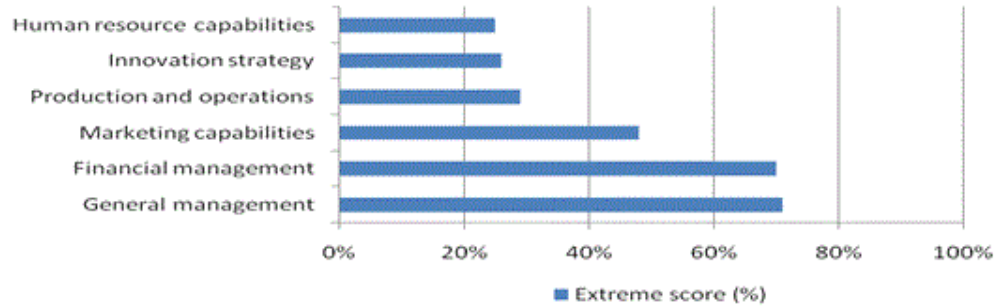
Figure 2: The importance of internal factors causing bankruptcy (Source: Adapted from Statistics Canada